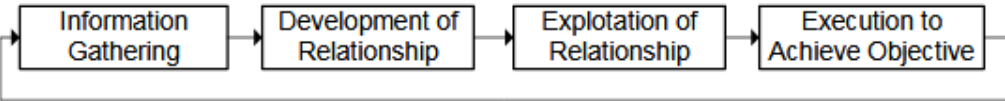
Figure 2: Social engineering attack cycle. Source: Airehrour et al.